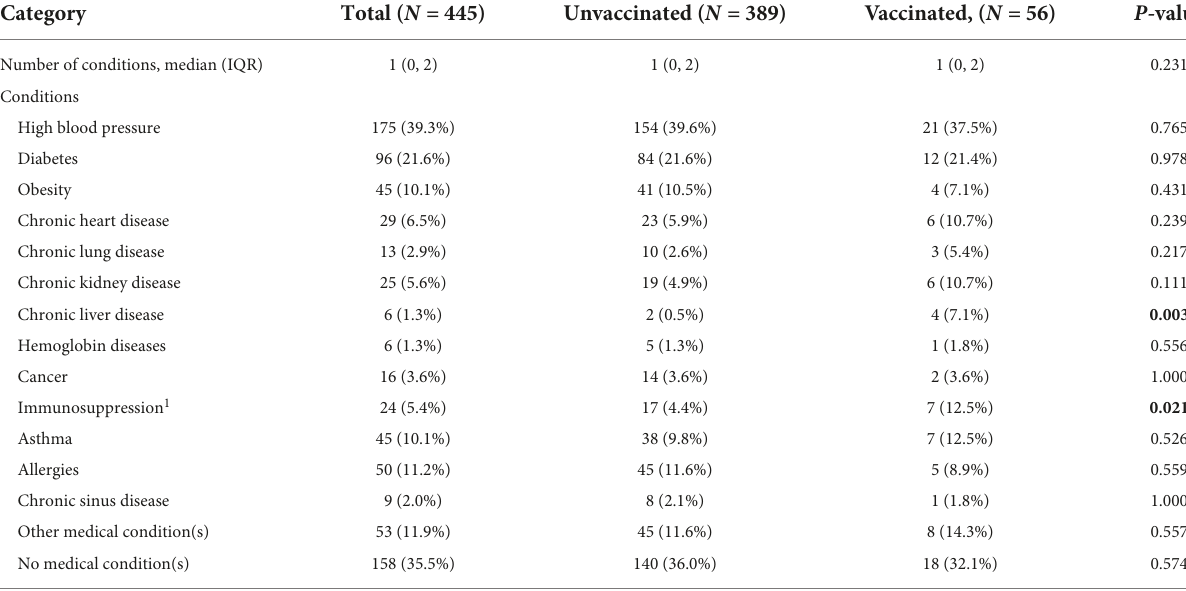
TABLE 2 Medical conditions in SARS CoV-2 (+) unvaccinated and vaccinated [partially ( n = 36) and fully ( n = 20)] groups. Category